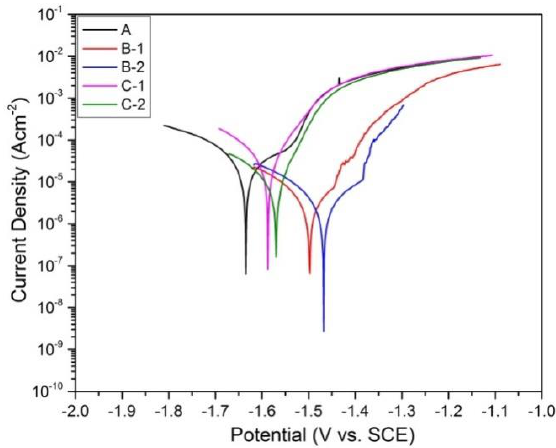
Figure 9. Potentiodynamic polarization curves of as fabricated samples in Hanks’ solution.